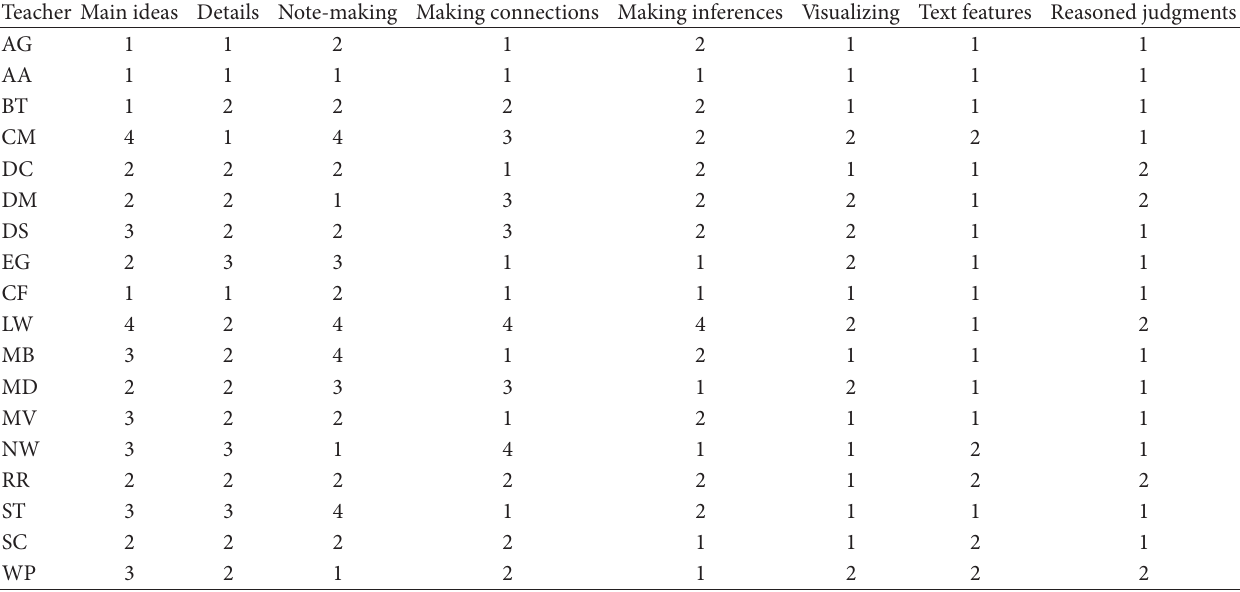
T 5: Implementation quality (1–4) for each teacher for each targeted